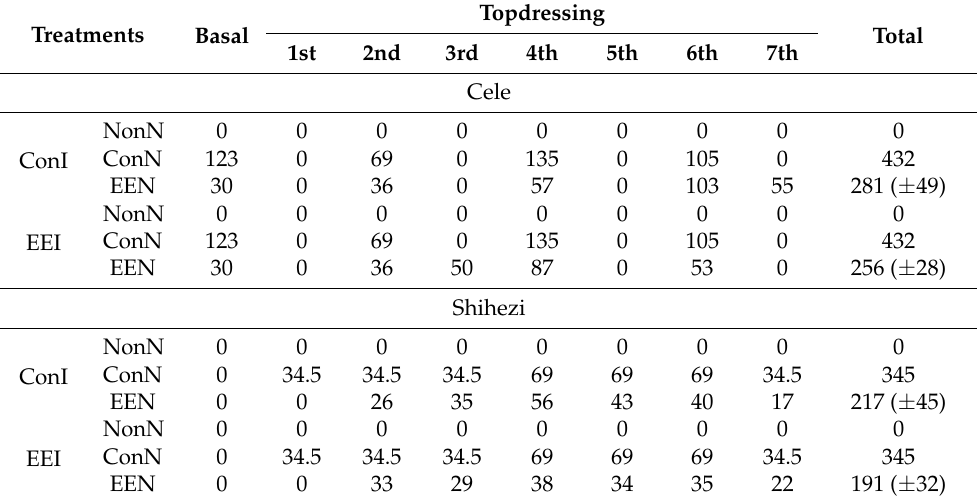
Table 3. Nitrogen rates (kg ha − 1 ) under different nitrogen fertilization managements of two experi- mental sites.